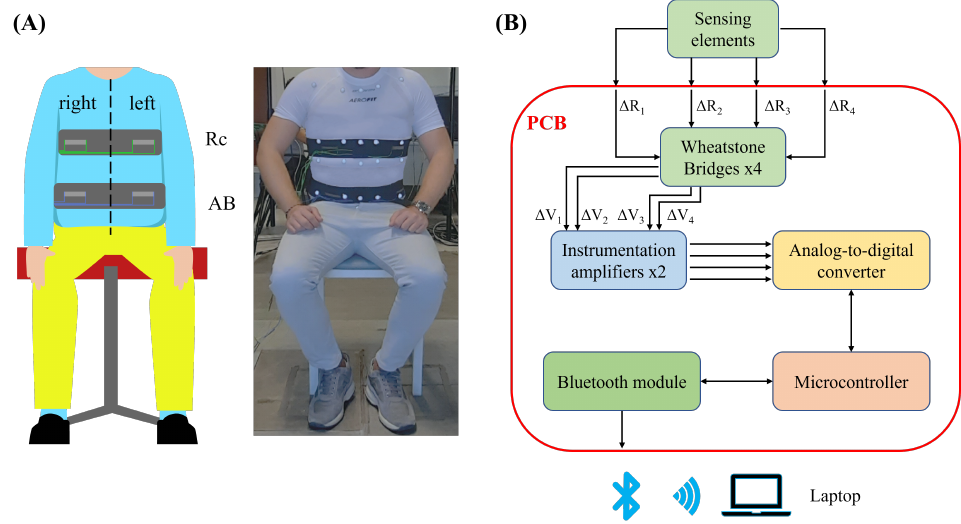
Figure 1. ( A ) Graphical representation of the position of the elastic bands on the chest wall and of the position of each sensor on the elastic band, and ( B ) measurement chain diagram representing all the WD